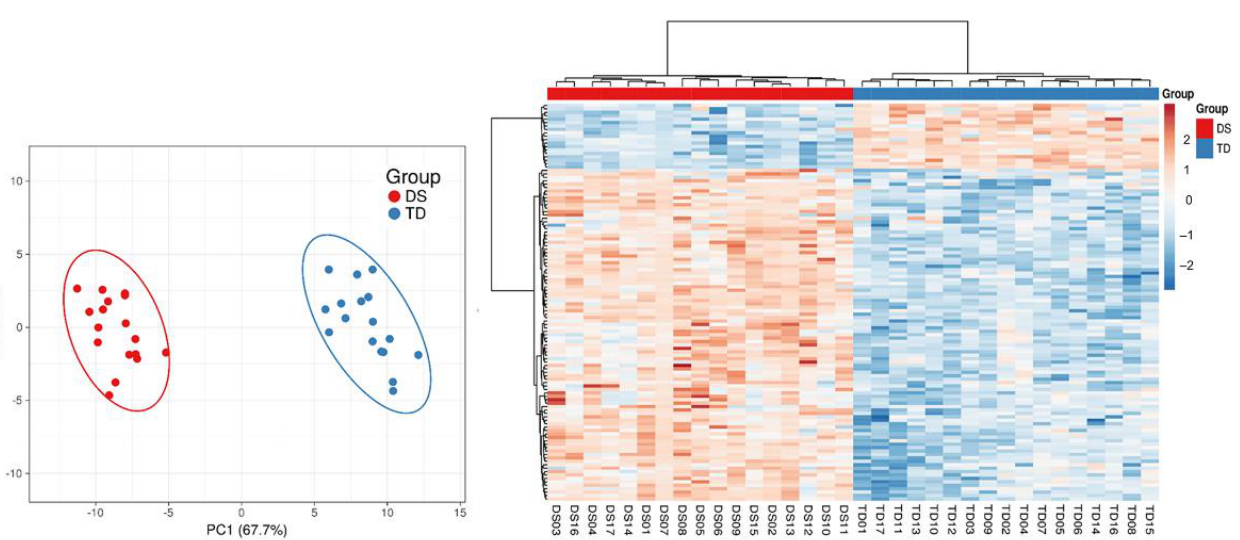
8 of 17 Figure 5. Hierarchical clustering trees summarizing the results of the Gene Ontology—GO:Biologi- cal Process ( a ), GO:Molecular Function ( b ), and GO:Cellular Component ( c )—and Human Pheno- type Ontology ( d ) overrepresentation tests performed for the set of genes differentially methylated (DMGs) in DS (Table S4). The trees were constructed using ShinyGO tools [25]. The top 10 GO terms overrepresented in the DMGs set ranged by the enrichment p -value are shown. Functional catego- ries are clustered based on the number of shared genes; bigger dots indicate more significant p - values. As shown in Figure 5, the GOs most significantly overrepresented among the DMGs are those involved in the transcription regulation (Figure 5b) related to developmental processes, particularly, the central nervous system development and function (Figure 5a,c). Concerning the potential association with particular phenotypic features, the DMGs have been linked to a broad spectrum of diseases and phenotypic abnormalities (most of which are assigned to a group of autosomal-dominant disorders) that have a high preva- lence in DS. Thus, the HPOs listed in Figure 5d include phenotypic characteristics often associated with disorders and conditions in DS, including megalocornea, which is often associated with ocular disorders in DS [35], pediatric hernias [36], cardiovascular system conditions [37], and others. 3.4. Differentially Methylated Regions (DMRs) in DS vs. TD Toddler Groups An analysis of the differentially methylated CpG clusters using the bump-hunting algorithm, following the adjustment for the variation in cell-type proportions, revealed